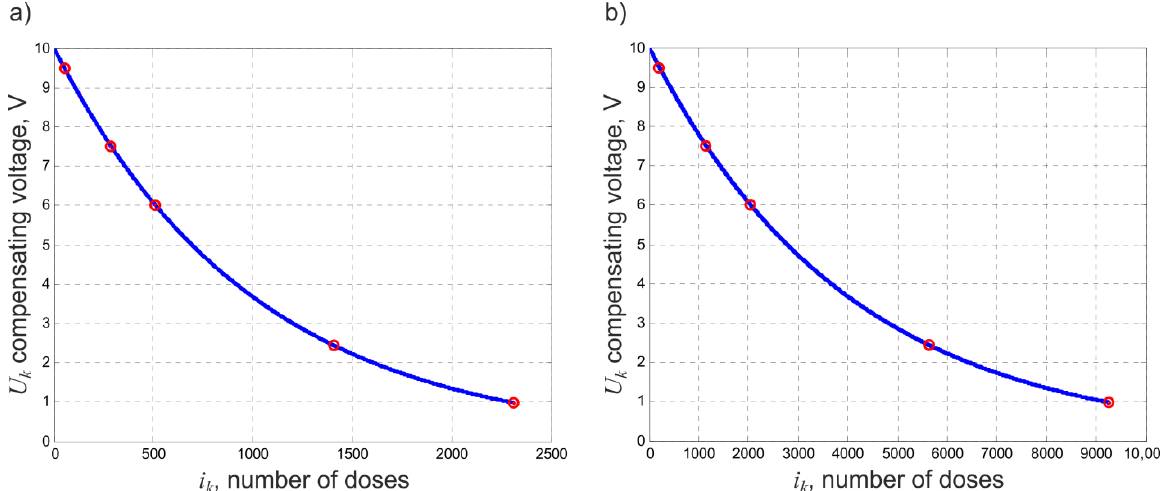
Figure 3. Operation graphs of the multifunctional ADCF converter for five input voltages: U IN 1 = 9.5 V; U IN 2 = 7.5 V; U IN 3 = 6 V; U IN 4 = 2.44 V; U IN 5 = 0.99 V for the given errors: ( a ) 0.1% and ( b ) 0.025%.